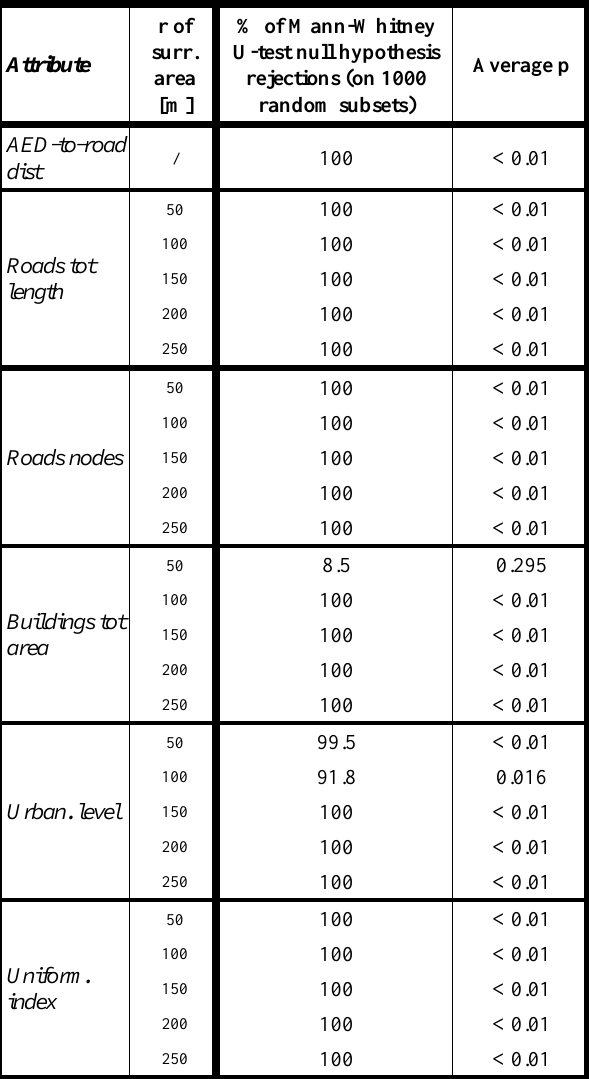
Table 3. Results of 1000 repeated Mann-Whitney U-tests between ‘failures’ group and equally sized random subsets of ‘positives’ group (see text for